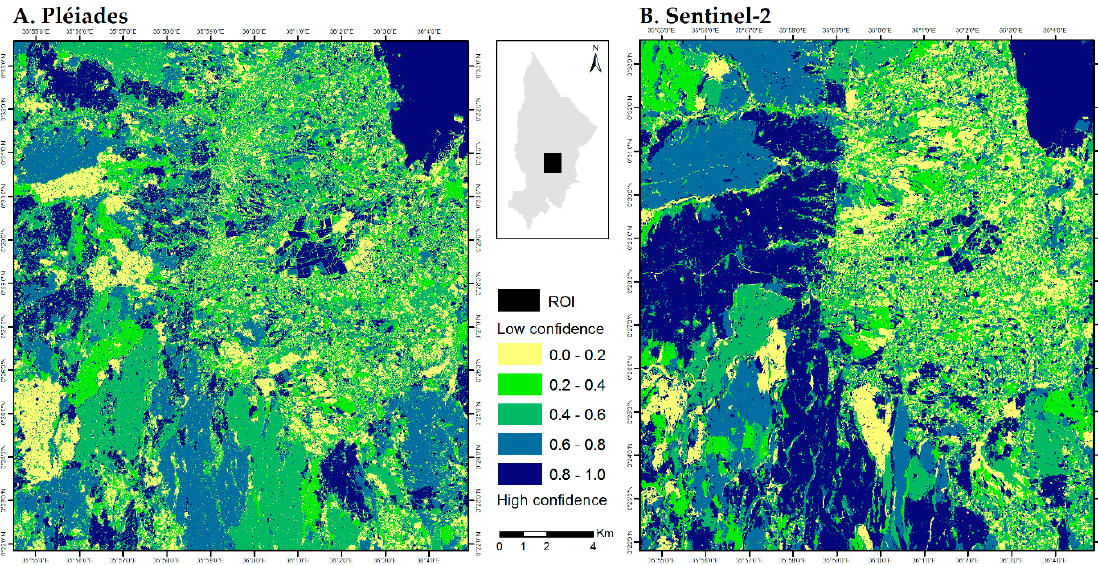
Figure 8. Margin maps indicating the expected quality of the classification results: ( A ) Pléiades; and ( B ) Sentinel-2.